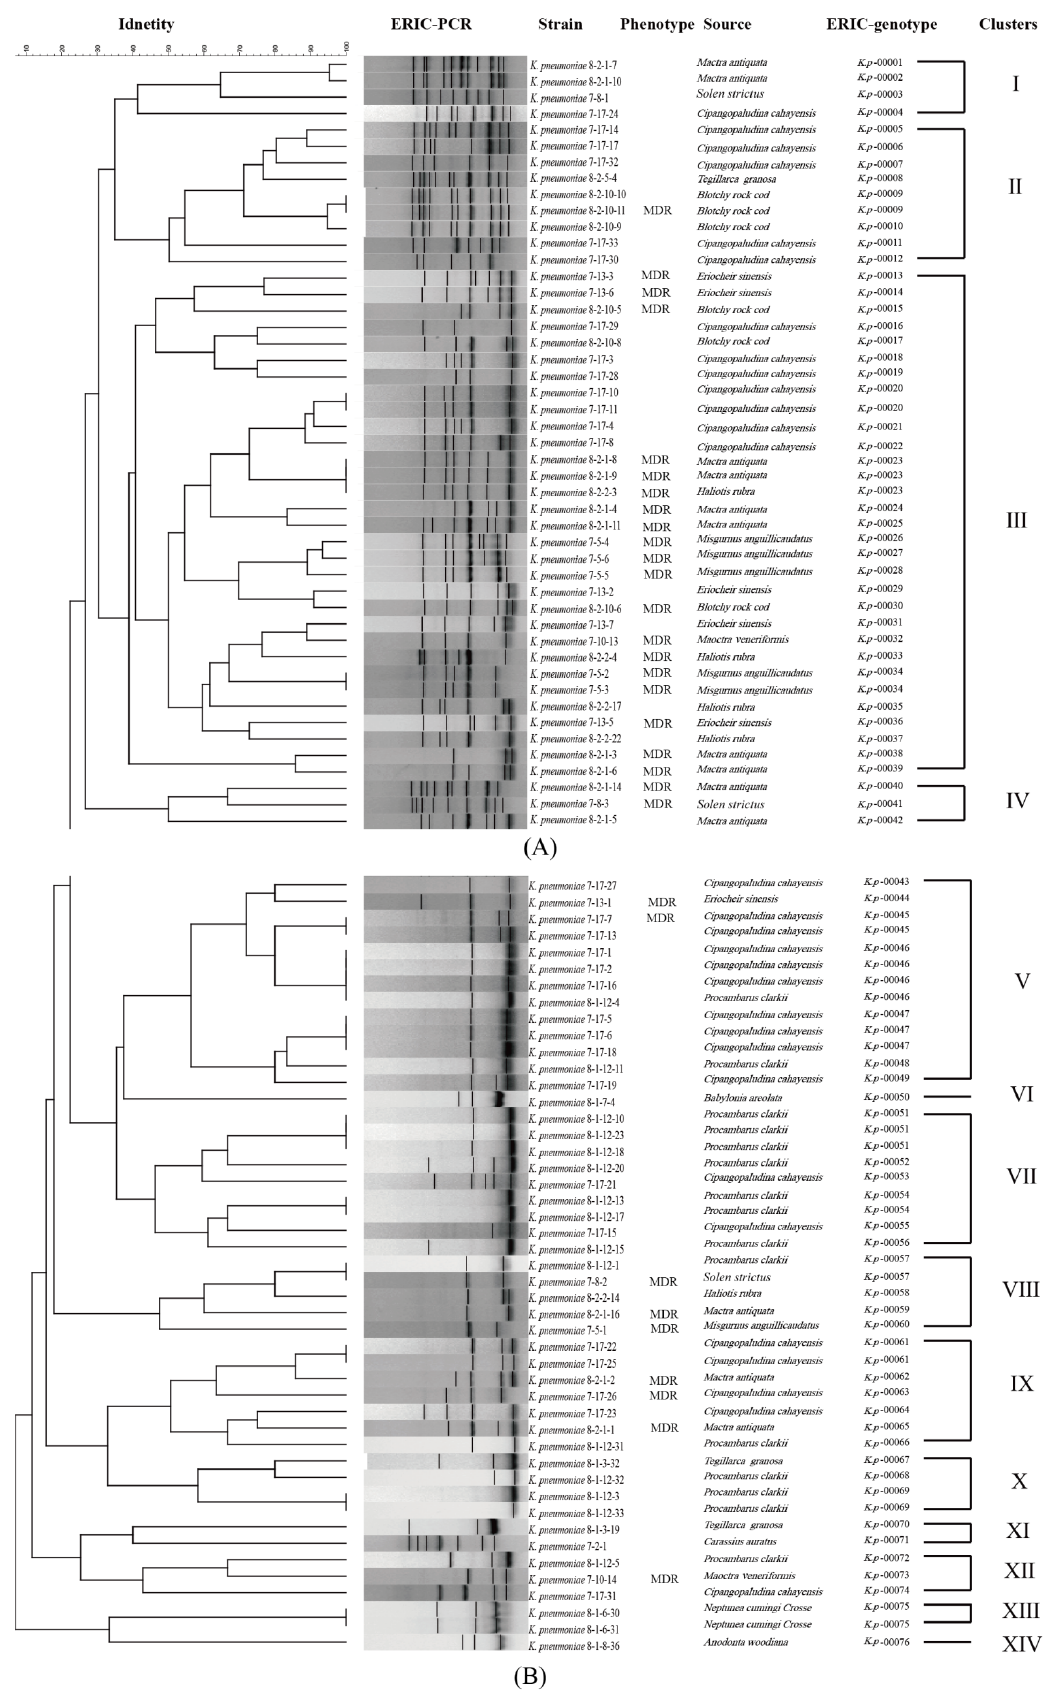
Figure 2. The ERIC-PCR-based genotyping of the 94 K. pneumoniae strains ( A , B ).